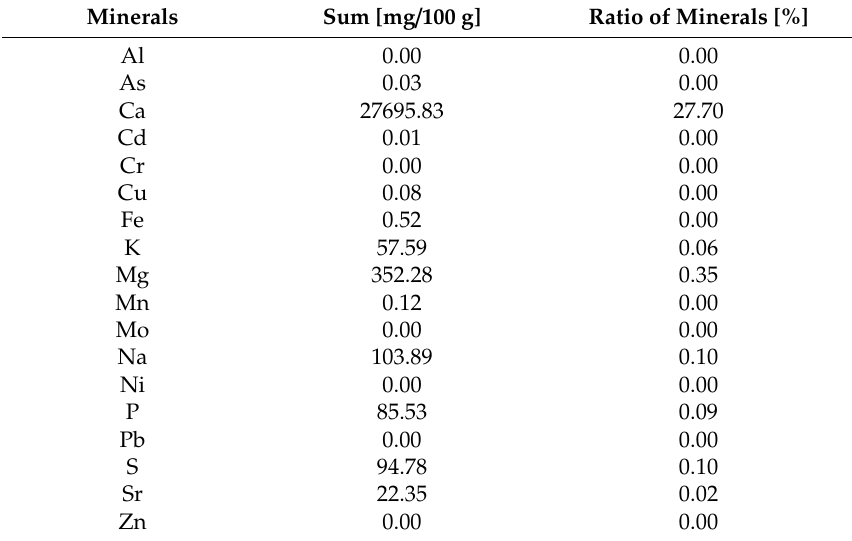
Figure 4. E ff ect of eggshell addition on mineral compounds changes in berry juices before thermal treatment. *Ch, chokeberry; Cr, cranberry. Table 3. Minerals content in